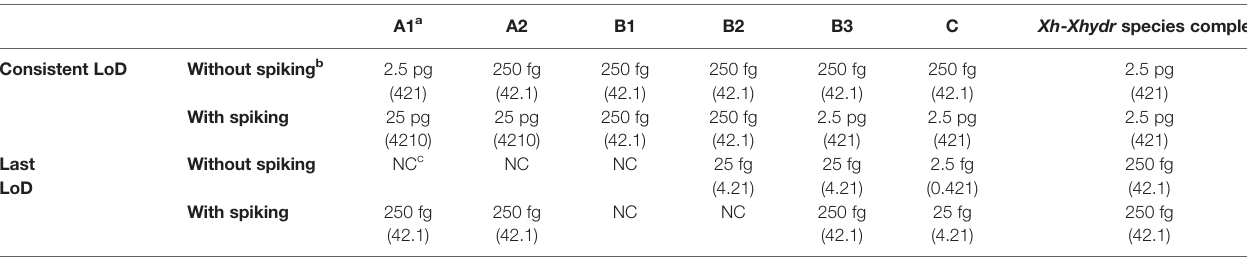
a CladeA1: X.hortorum pvs.cynarae,gardneriandvitians,cladeA2: X.hortorum pv.taraxaci,cladeB1: X.hortorum pv.hederae,cladeB2: X.hortorum pv.carotae,cladeB3: X.hortorum pv.pelargonii,cladeC: X.hydrangeae,Xh-Xhydr speciescomplex: X.hortorum – X.hydrangeae speciescomplex. b Withoutandwithspikingcorrespondheretotheomissionandaddition of plant cell extracts in the steel ball-bearing tube used to prepare the LAMP DNA template, respectively. c NC: no change (i.e., same consistent and last detection limits).